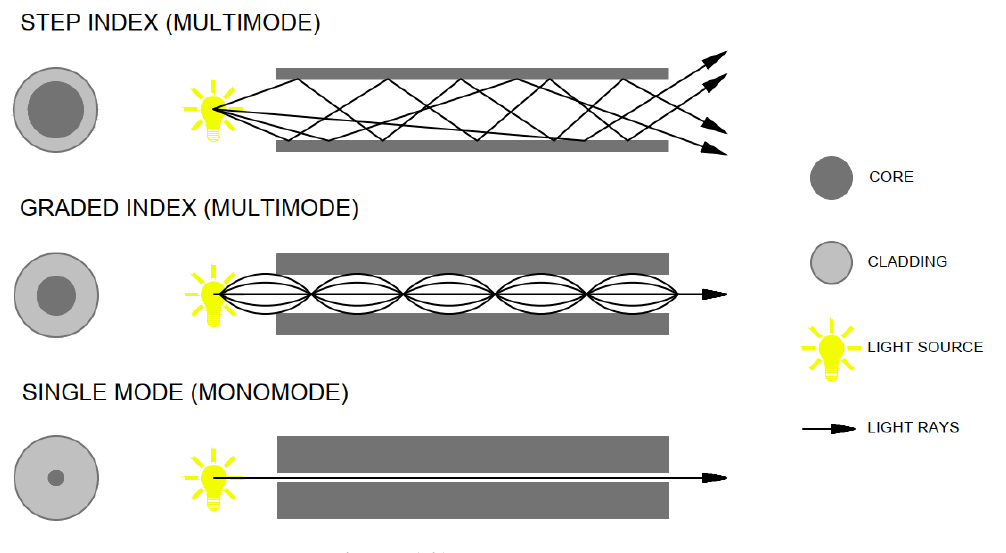
Figure 7. Types of optical fibers.